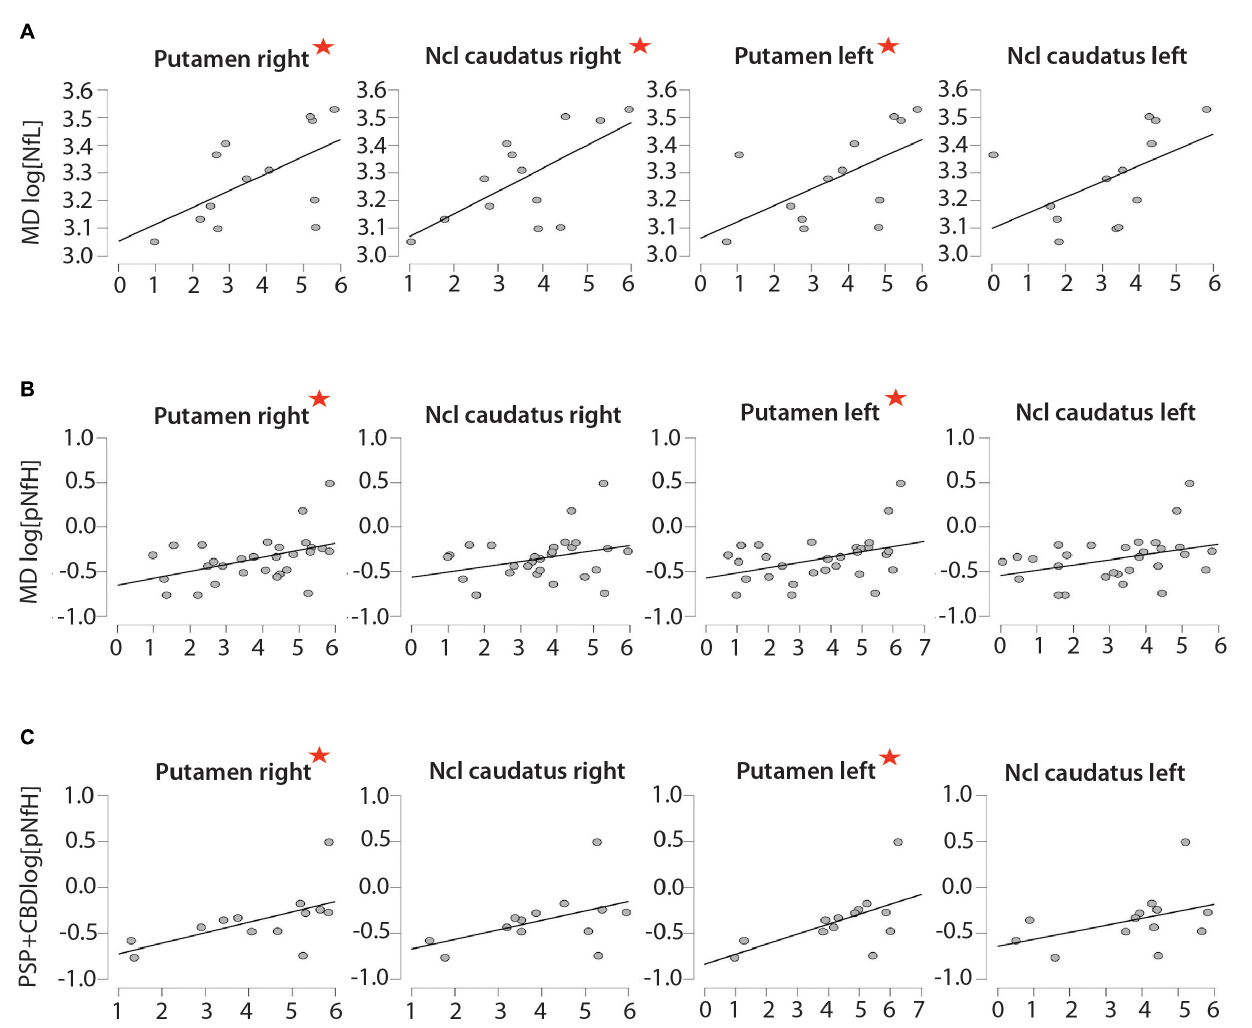
FIGURE 2 | Correlations between neurofilament proteins and dopamine transporter single photon emission computed tomography (DaTscan). Correlations between CSF levels of (A) NfL and (B,C) pNfH and the results of DaTscan (Z-scores indicating the decrease in uptake compared with a normal collective) in patients with (A,B) movement disorders and (C) progressive supranuclear palsy + corticobasal degeneration (PSP + CBD). The red asterisk is indicating the significant difference. The x -axis shows the Z-scores of the DaTScan and on the y -axis the log (biomarker level).